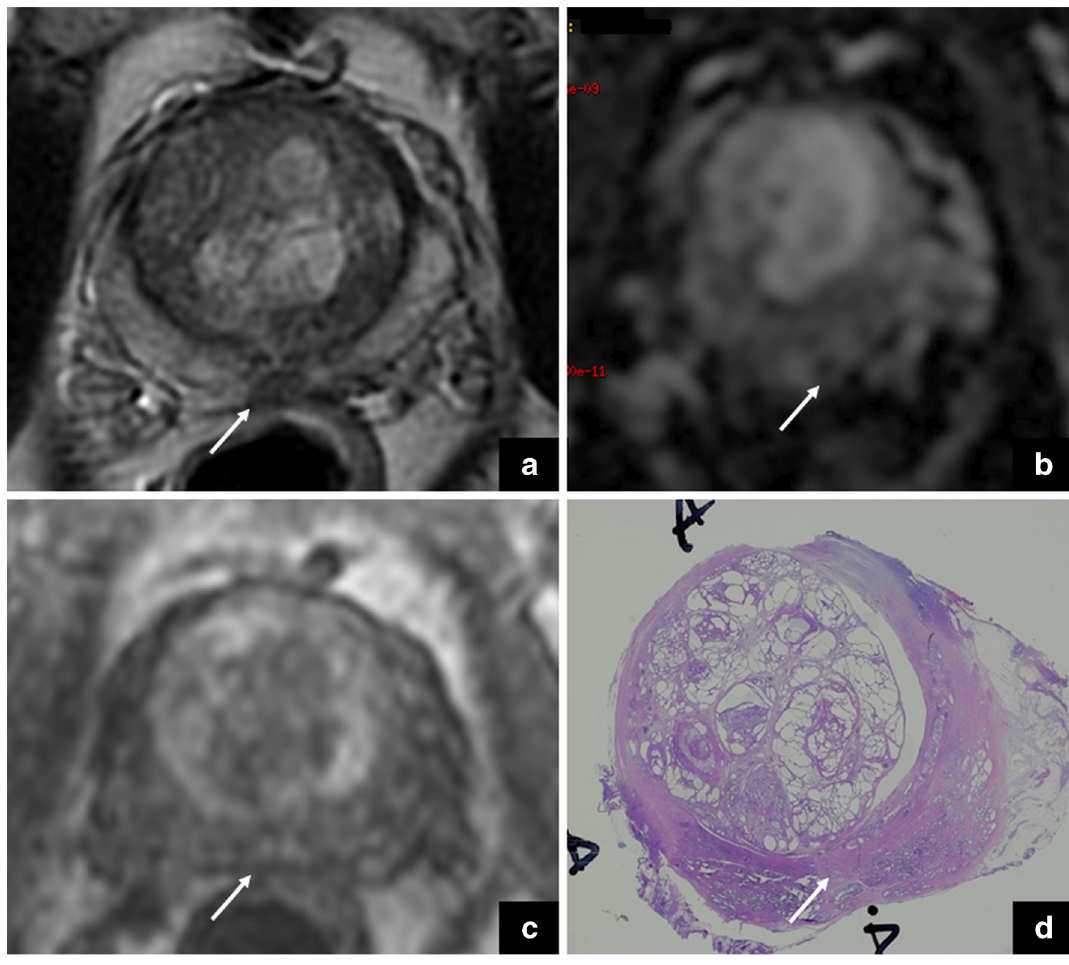
Fig. 10 Axial T2-weighted image ( a ) that shows a focal area of low signal intensity adjacent to the ejaculatory ducts (white arrow). This corresponds to an area of restricted diffusion on the ADC map ( b ) and